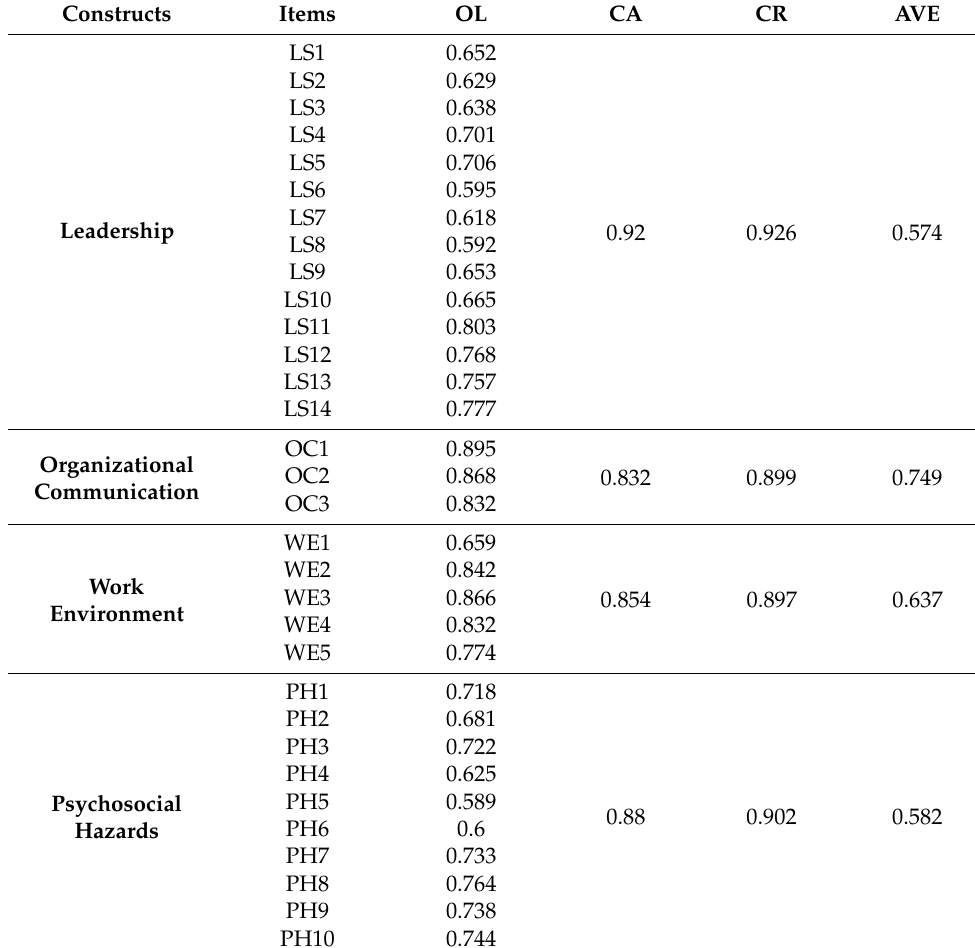
Table 3. The outcomes of convergent validity and reliability.